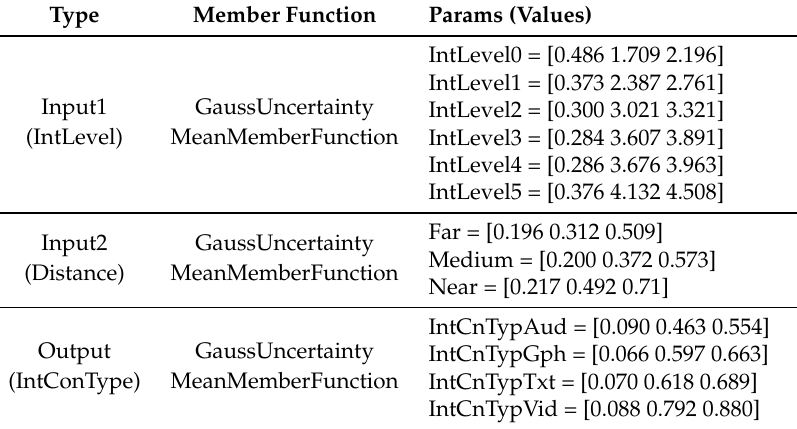
Table 3. Inputs, outputs data mined Type-2 FIS configuration.